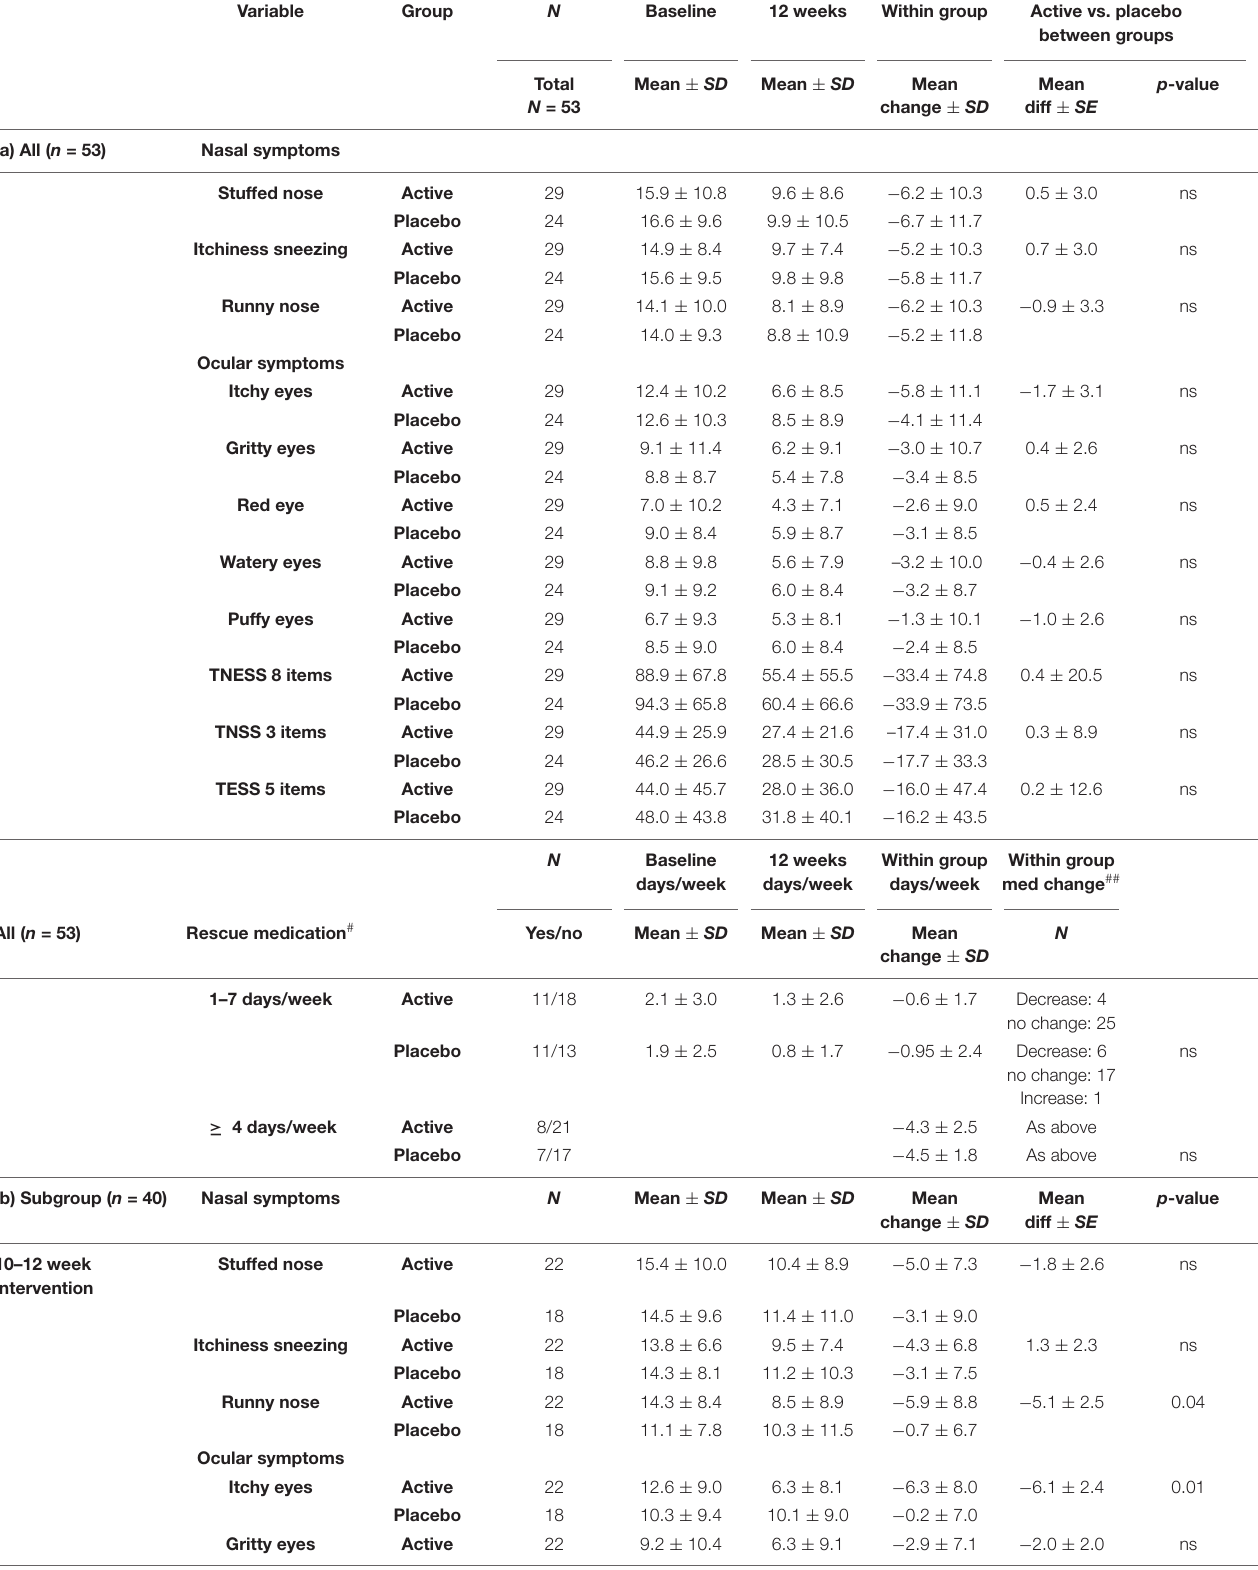
TABLE 4 | Total nasal and eye symptom score and rescue medication intake. Variable Group N Baseline 12 weeks Within group Active vs. placebo